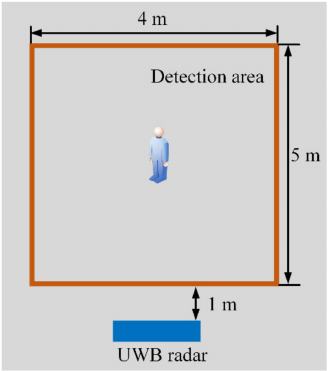
Figure 13. Experiment scene.